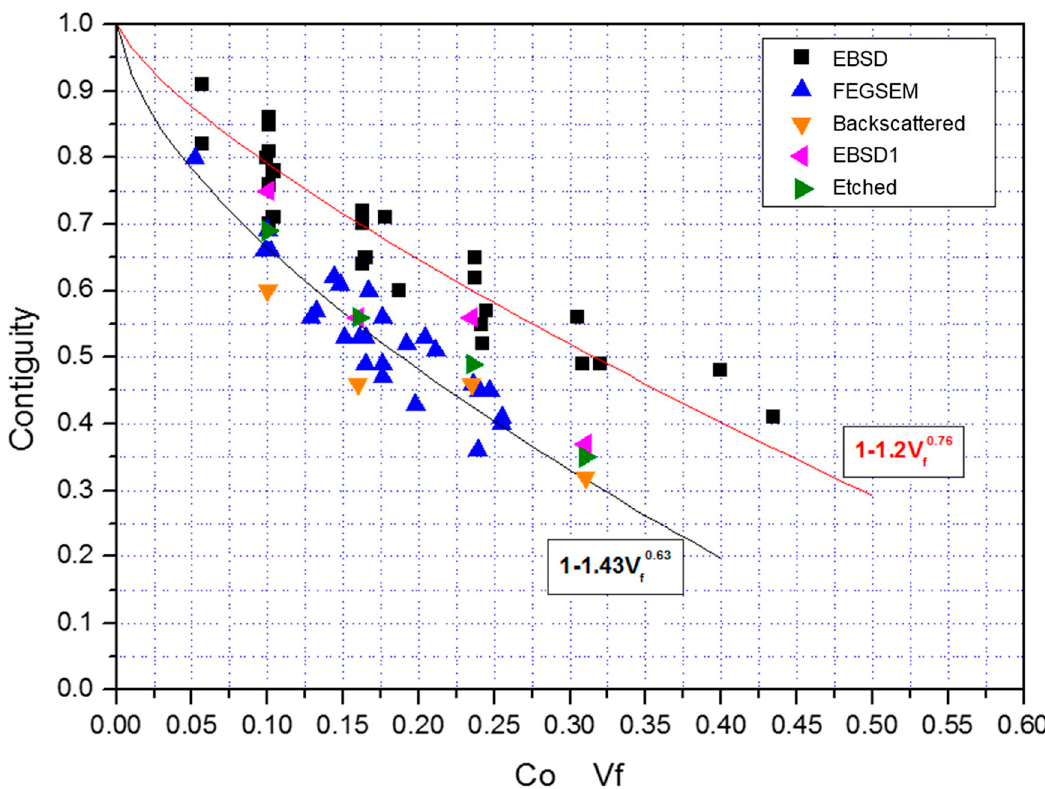
Figure 9. Average contiguity results measured in this interlaboratory exercise (backscatter, EBSD1 and etched) compared with EBSD and high-resolution Field Emission Gun Scanning Electron Microscope (FEGSEM) data shown in Figure 1.